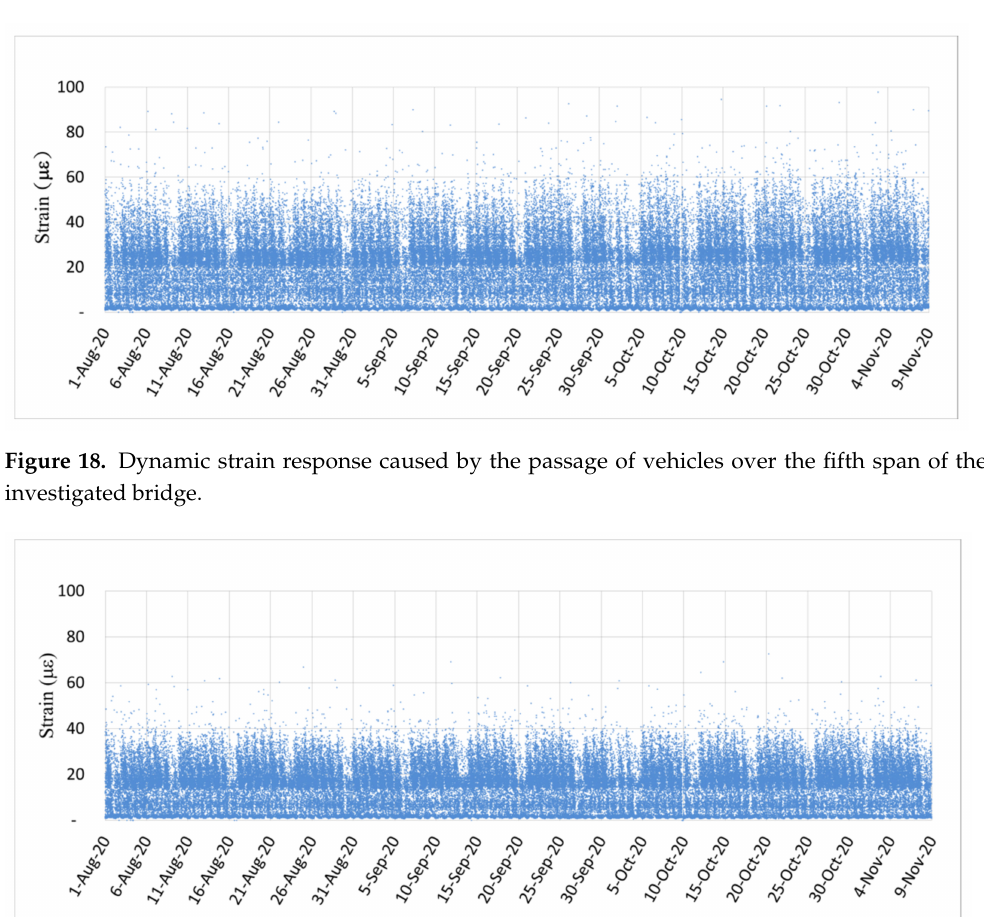
Figure 19. Dynamic strain response caused by the passage of vehicles over the seventh span of the investigated